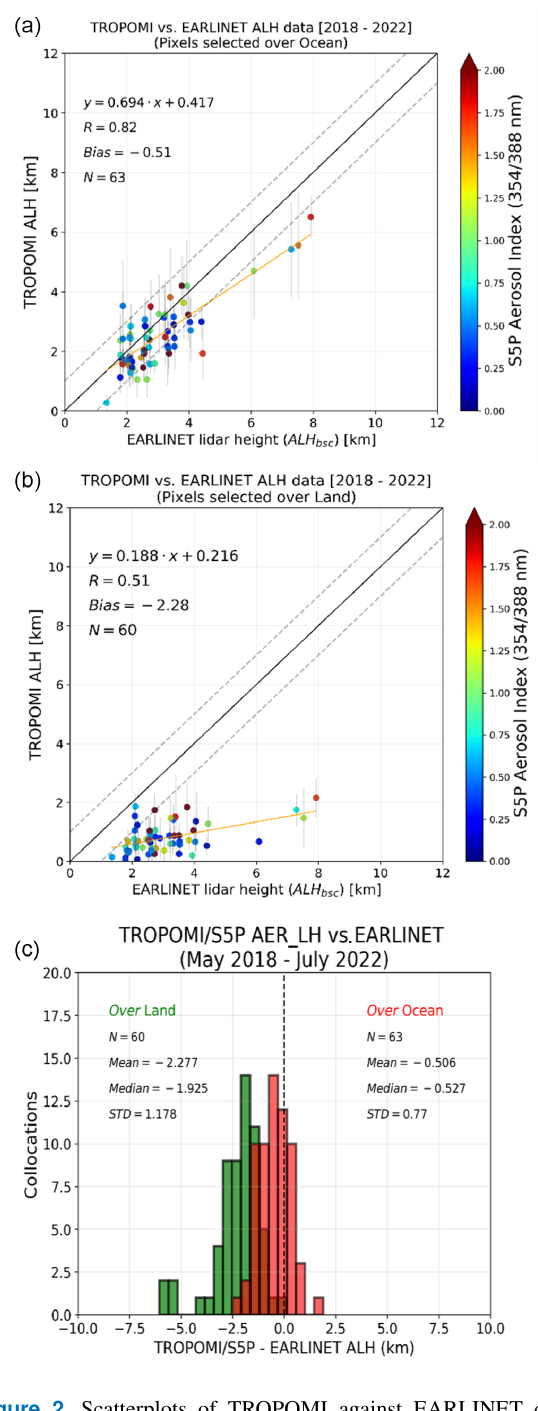
Figure 2. Scatterplots of TROPOMI against EARLINET data: (a) TROPOMI pixels over ocean and (b) over land. The colour of each scatter point indicates the TROPOMI-retrieved UVAI values, and the error bars of each scatter indicate the spatial variability of the averaged TROPOMI ALH pixels. (c) Histogram of the differ- ences between TROPOMI and EARLINET data sets, shown in red over the ocean pixels and green for both ocean and land